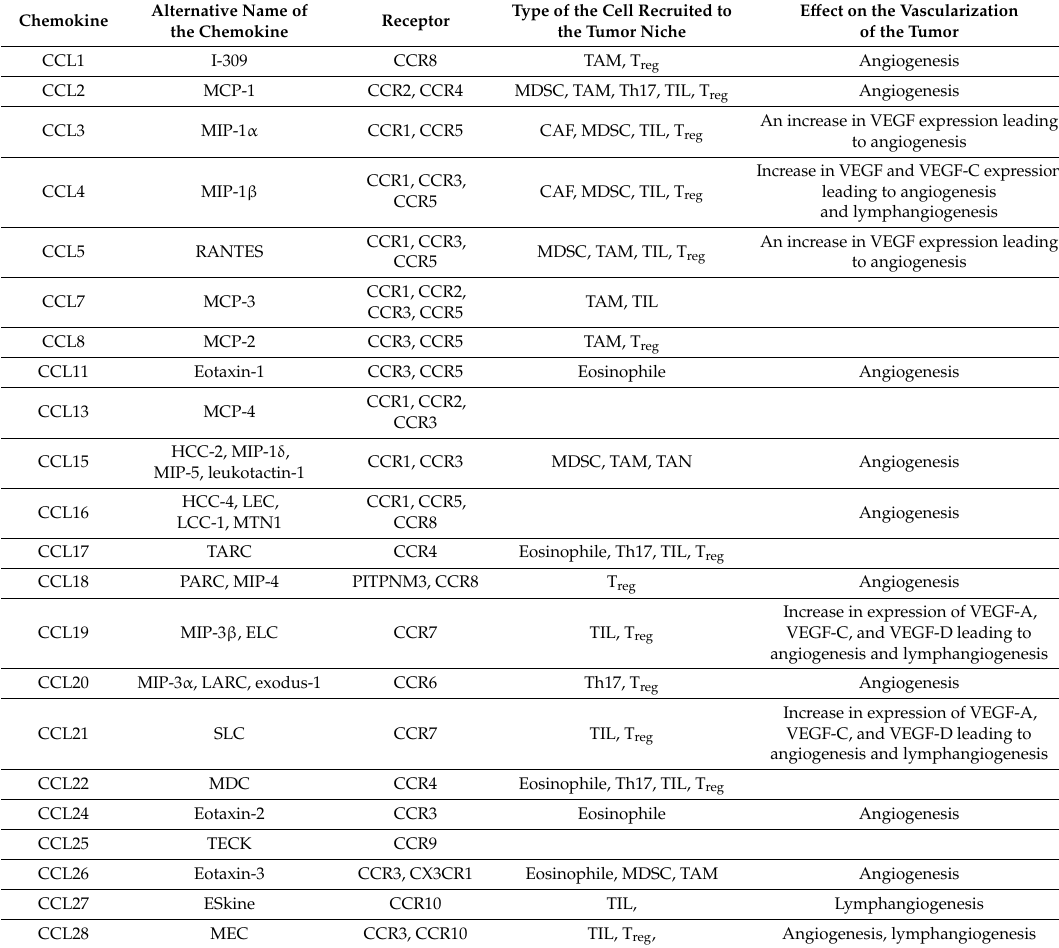
Table 1. Characteristics of the chemokines discussed in this review, including the impact on the recruitment of cells to the tumor